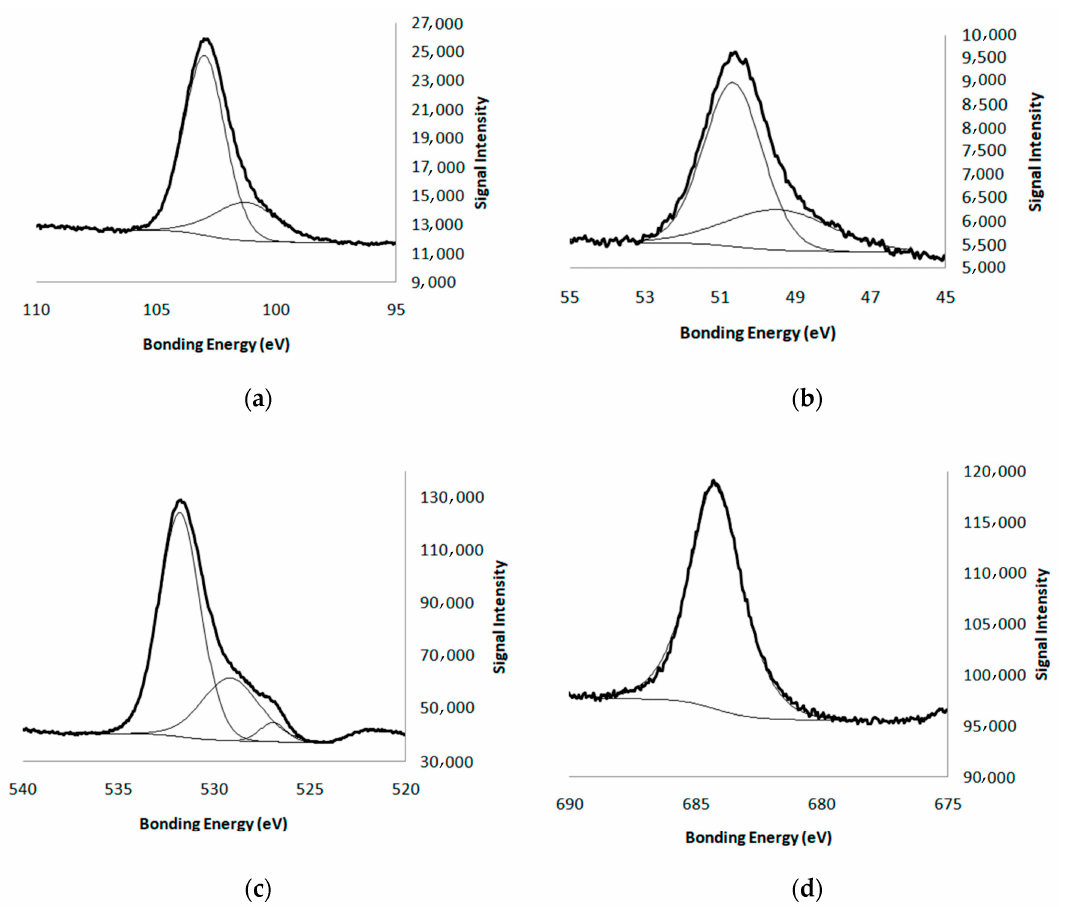
Figure 4. XPS spectra of the main elements present in the fluorohectorite: (a) Si 2p, (b) Mg 2p, (c) O 1s and (d) F 1s. Table 3. Surface atomic concentration, binding energy and atomic ratios of elements of fluorohectorite Li-FH determined by